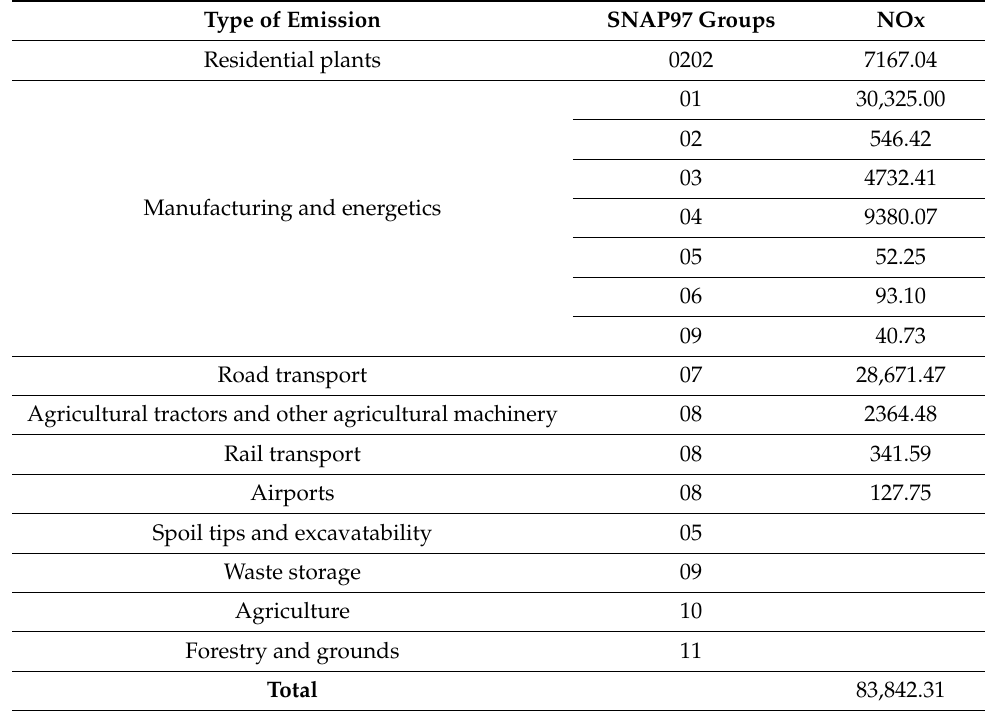
Table 10. Emission of NOx in 2018